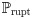
Rationale for our novel formulation (left) and exemplary visualization of its estimation (right).The probability of rupture, ℙrupt, is calculated as the volume of the probability distribution p(σvmmax,σγ) within the triangular-shaped area marked in red.